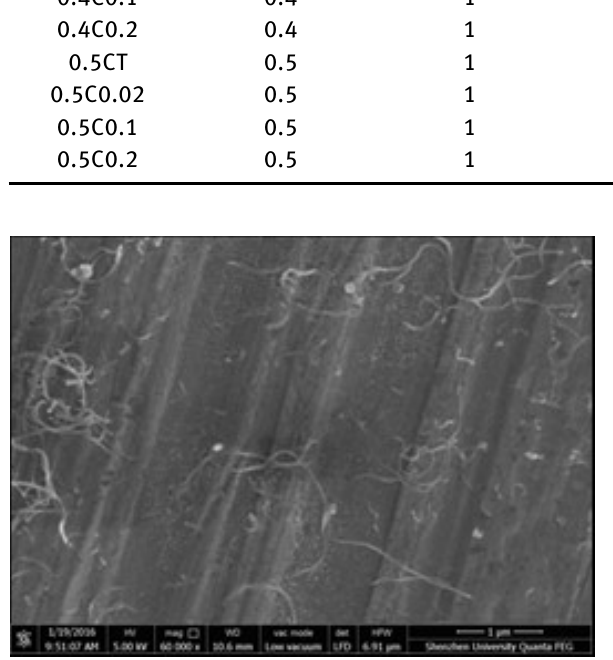
Figure 2: SEM image of MWCNTs after